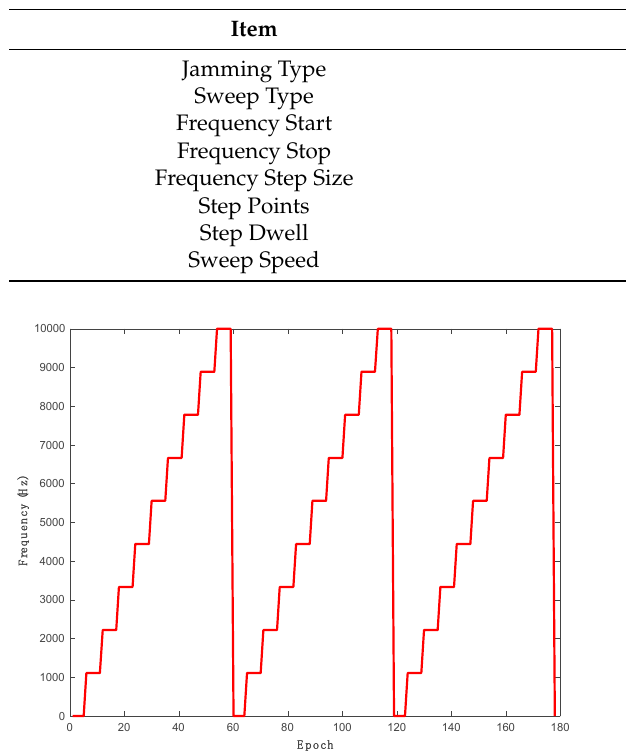
Table 1. Jamming signal parameters.